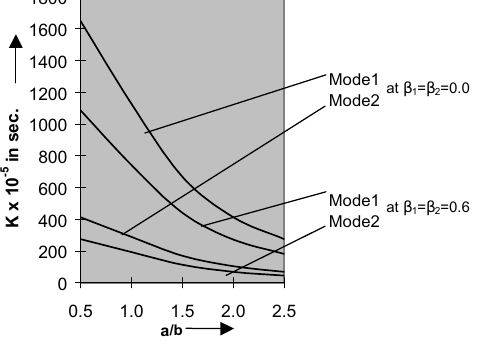
Fig. 3. Time period k vs aspect ratio a/b of a clamped visco-elastic rectangular plate. β 3 β 2 β 1 + 2002)(10010 1 + 1050 1 + 1911